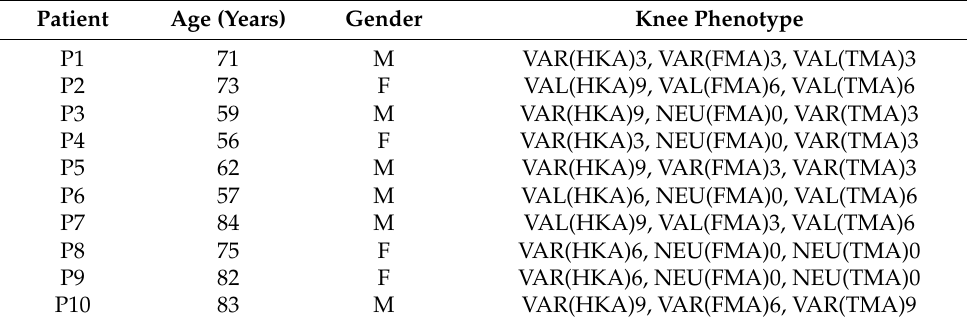
Table 1. Hip-Knee-Ankle (HKA) angle configurations of the analyzed knee